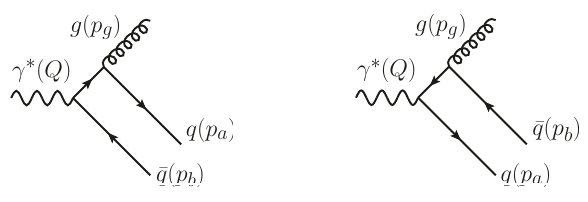
Figure 1 . Leading O ( α s ) QCD diagrams contributing to gluon